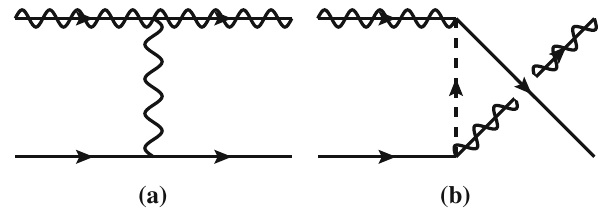
Fig. 1 Tree-level Feynman diagrams for DM-quark scattering, for the discussed s -channel ( a ) and t -channel ( b ) models